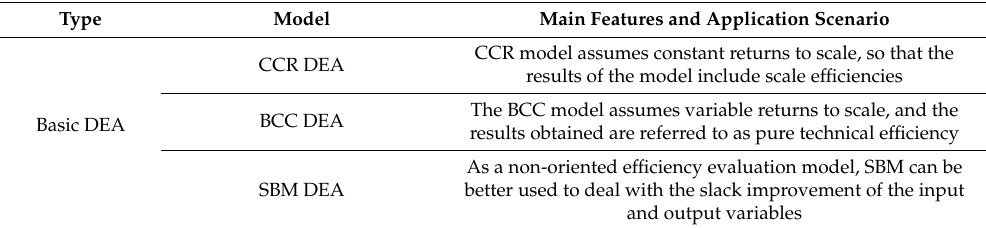
Table 1. The main features and application scenario of